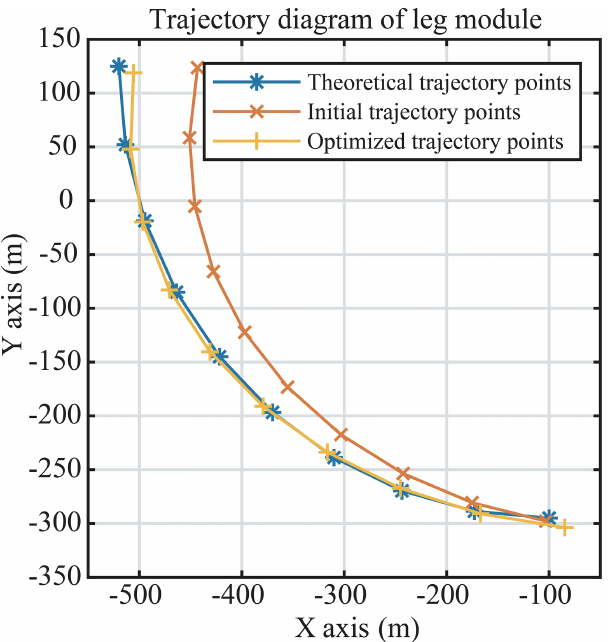
Figure 13. Trajectory diagram of the leg module.